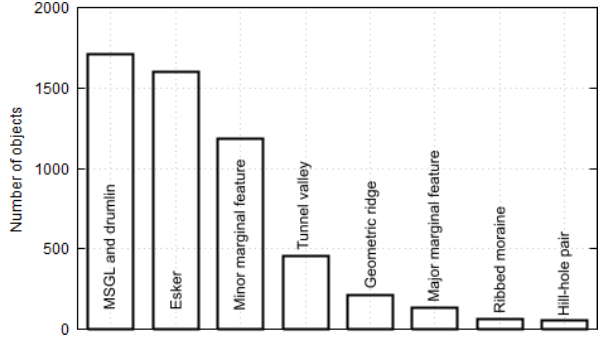
Figure 3. Number of objects for each of the mapped landform